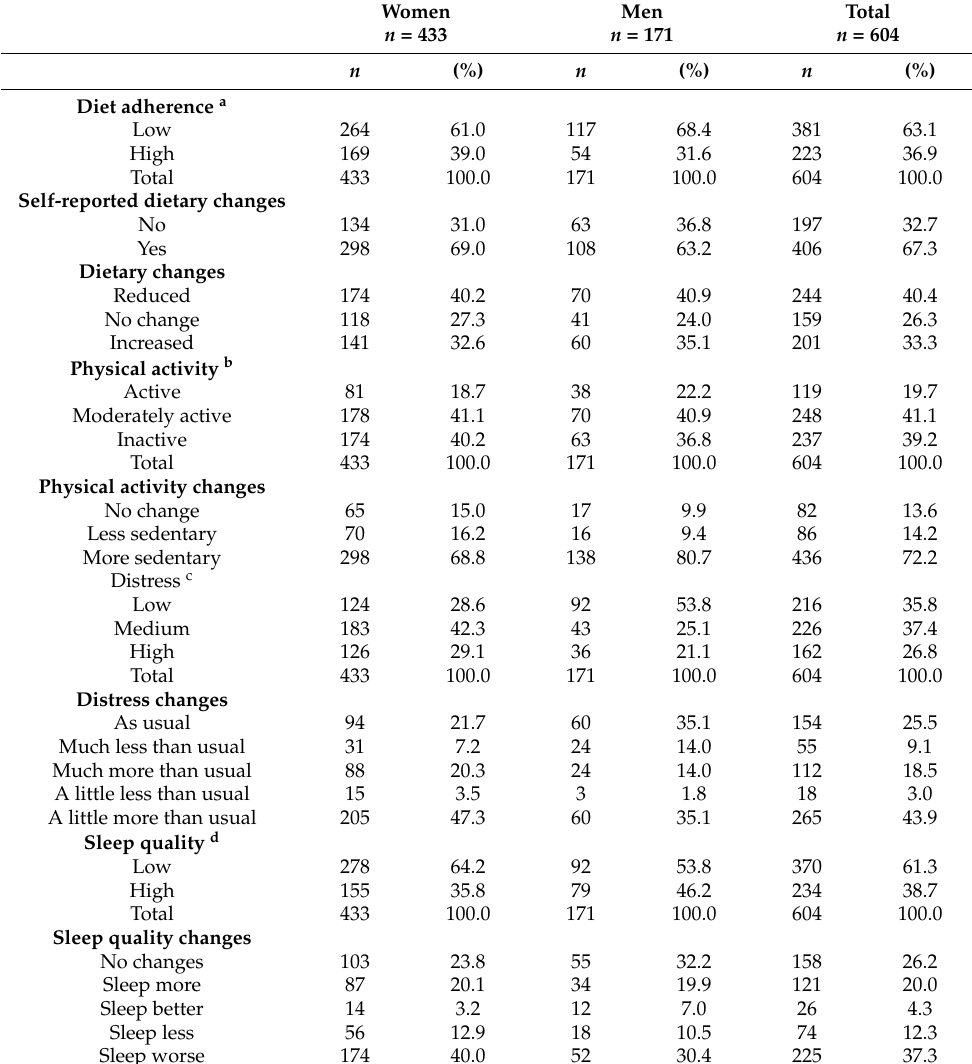
Table 2. Distribution of responses for diet, physical activity, distress, and quality of sleep and perceived changes, in the total subjects and by